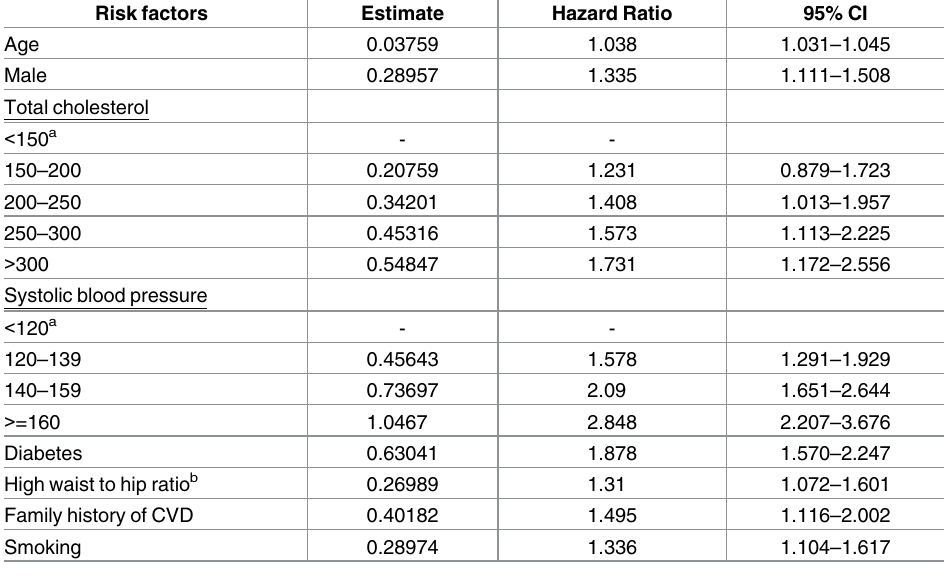
Table 4. Adjusted HRs for CVD risk factors using PARS risk function, ICS, 2001–2011.